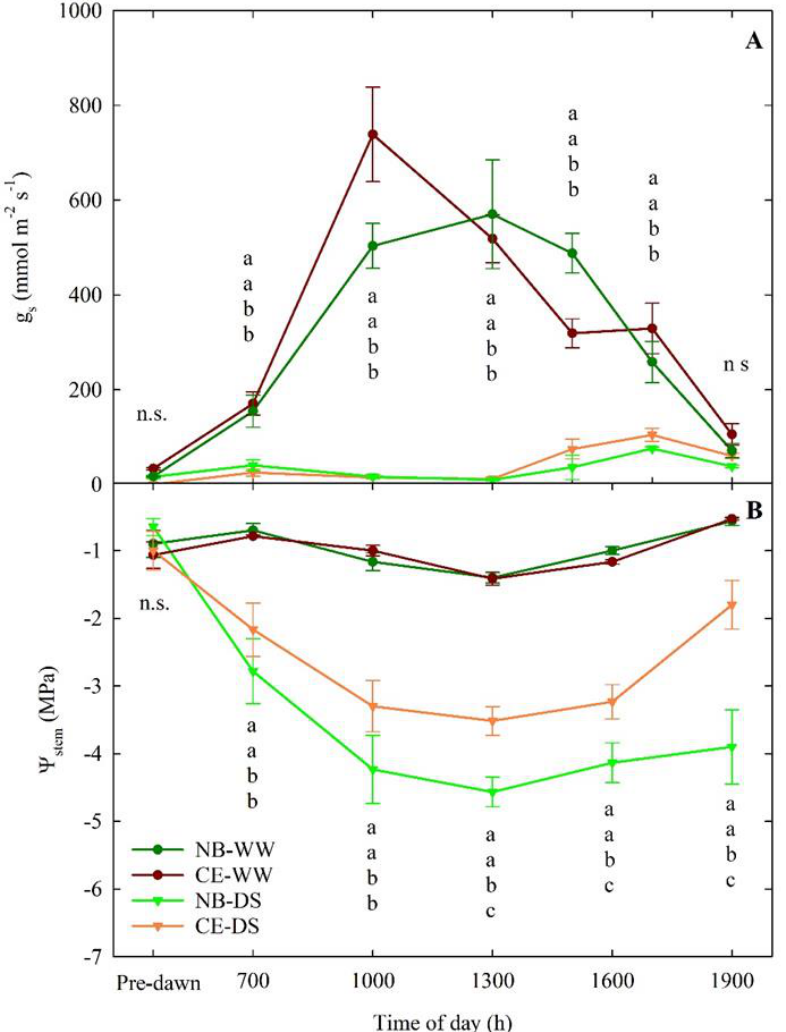
Figure 3. Daily−curves of leaf stomatal conductance (g s , A ) and stem water potential (Ψ stem , B ) of well-watered and drought-stressed ‘Nocellara del Belice’ (NB-WW and NB-DS, respectively) and ‘Cerasuola’ (CE-WW and CE-DS, respectively) olive trees. Measurements carried out on the 66 th day of drought stress (DODS; 3 August 2017). Error bars indicate the standard errors of the means. For each day, different letters indicate significant differences among treatments according to Tukey’s test following analysis of variance ( p < 0.05).